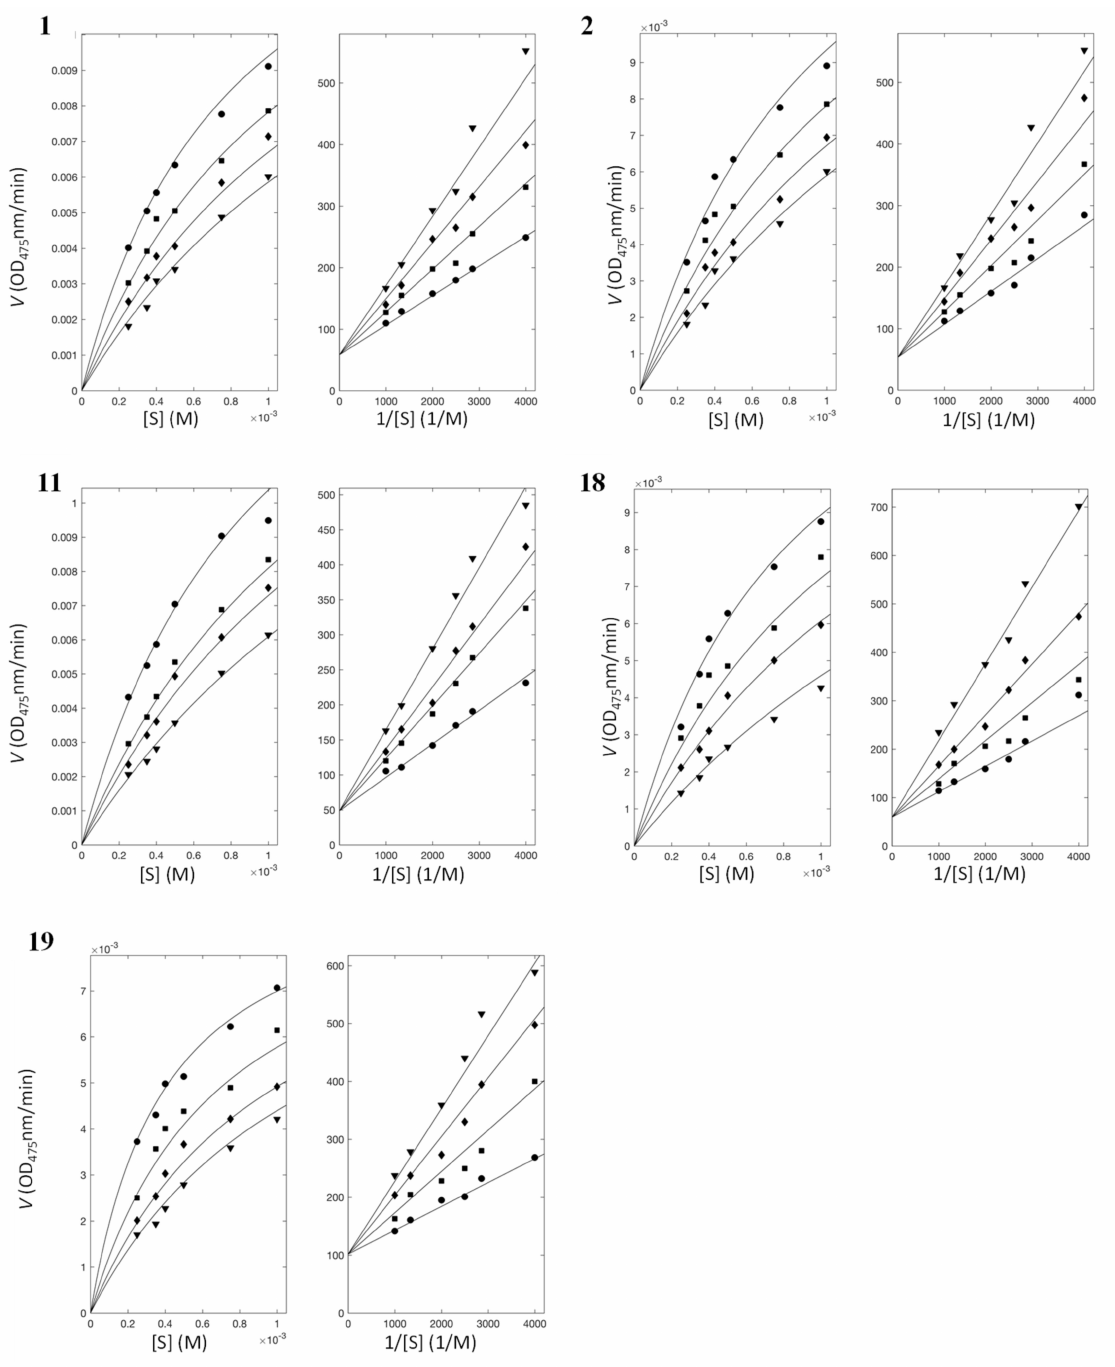
Figure 4. Enzyme inhibitory kinetics with T. versicolor . Left and right panels show Michaelis–Menten and Lineweaver–Burk plots, respectively, for each inhibitor: 1 , 2 , 11 , 18 , and 19 . • , (cid:4) , (cid:7) and (cid:72) represent inhibitor concentrations of 10, 20, 30, and 40 µ M for 1 ; 15, 30, 45, and 60 µ M for 2 ; 30, 50, 60, and 80 µ M for 11 ; 10, 20, 30 and 50 µ M for 18 ; and 20, 45, 70, and 90 µ M for 19